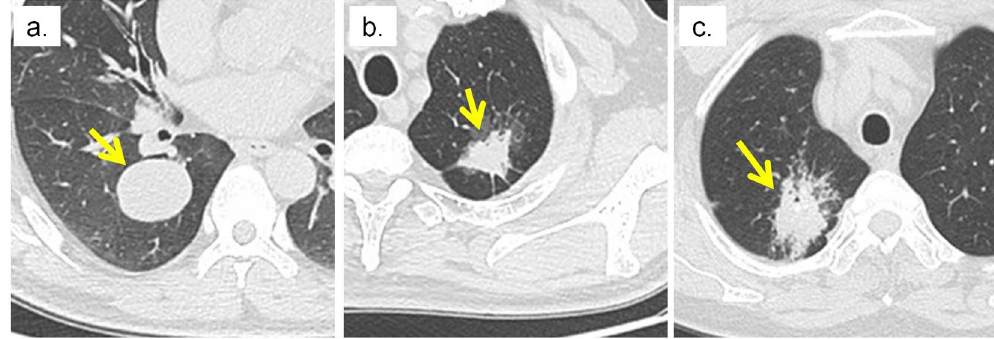
Figure 6. Tumors with different border definitions. ( a ) Tumor with a well-defined border (score = 1). ( b ) Tumor with neither a well- or poorly-defined border (score = 2). ( c ) Tumor with a poorly-defined border (score = 3). The arrow indicates the location of the